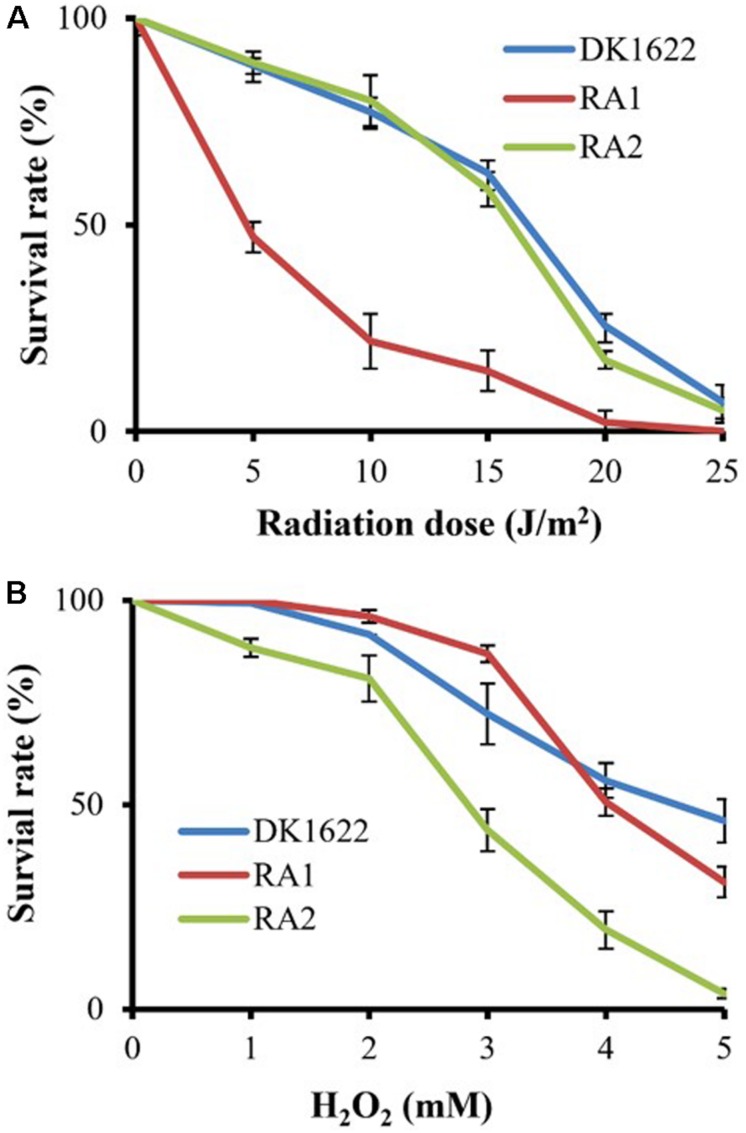
Survival of M. xanthus wild-type strain DK1622 and the mutants RA1 and RA2. (A) Survival curves after exposure to UV irradiation at different dosages (0–25 J/m2). (B) Survival curves after hydrogen peroxide treatment at different concentrations (0–5 mM). The percentage of surviving cells was calculated by comparing with the corresponding non-treated cells. The error bars indicate the SEM for six replicates.